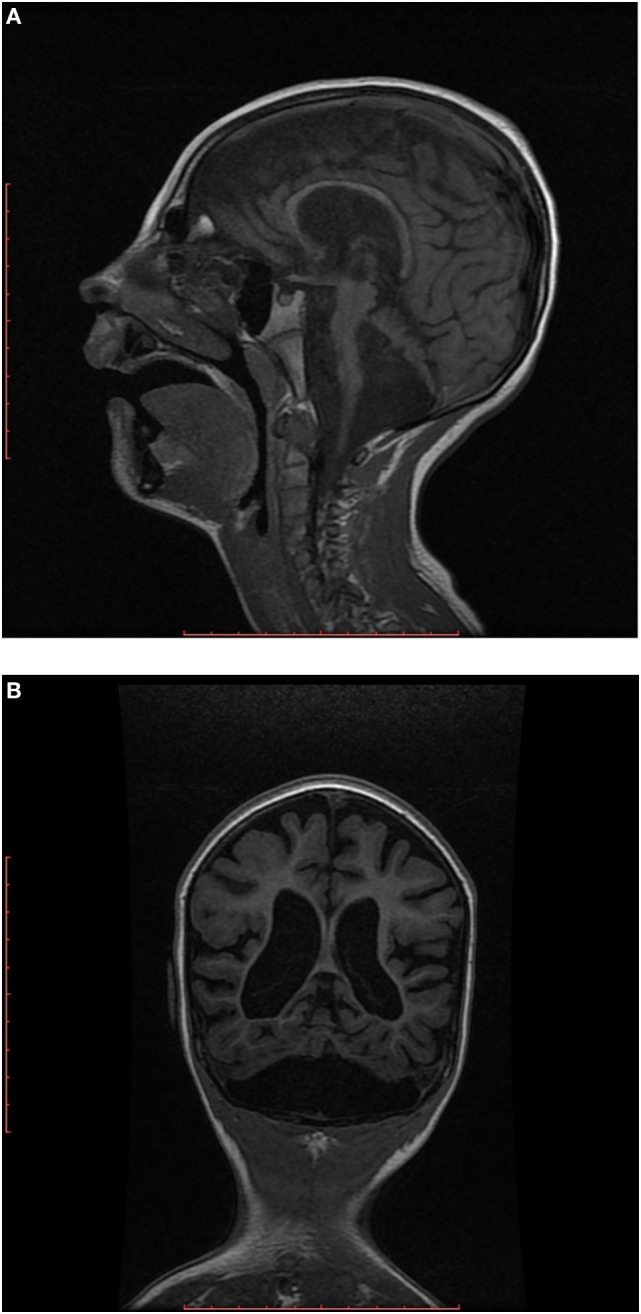
(A) Sagittal T1-weighted image shows hypoplastic cerebellum (cerebellar hemispheres more affected than vermis) associated with a small pons. (B) Coronal T1-weighted image shows markedly hypoplastic cerebellar hemispheres (dragonfly-like cerebellar pattern), with dilatation of the cisterna magna inferiorly and also cortical and cerebral atrophy.